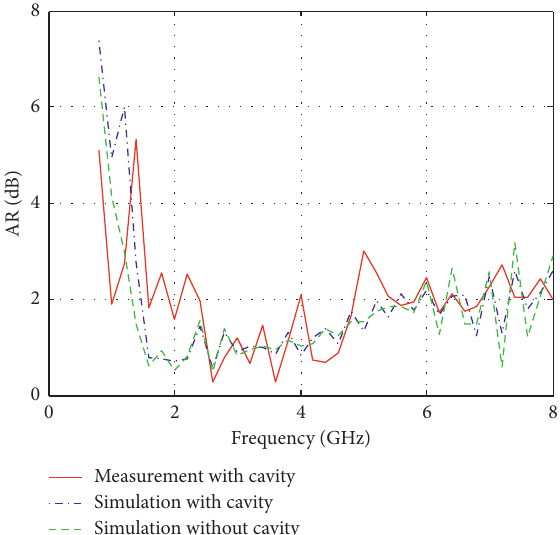
Figure 25: Measured ARs at different